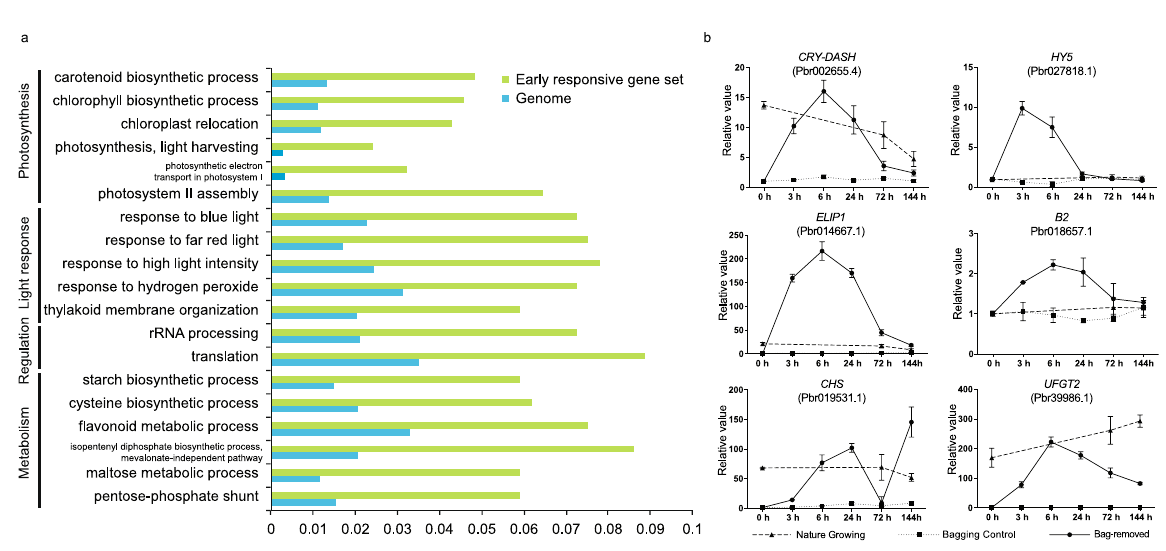
Figure 5. Analysis of the early-responsive genes. ( a ) Gene ontology enrichment analysis of early-responsive genes. ( b ) qPCR confirmation of the expression patterns of selected